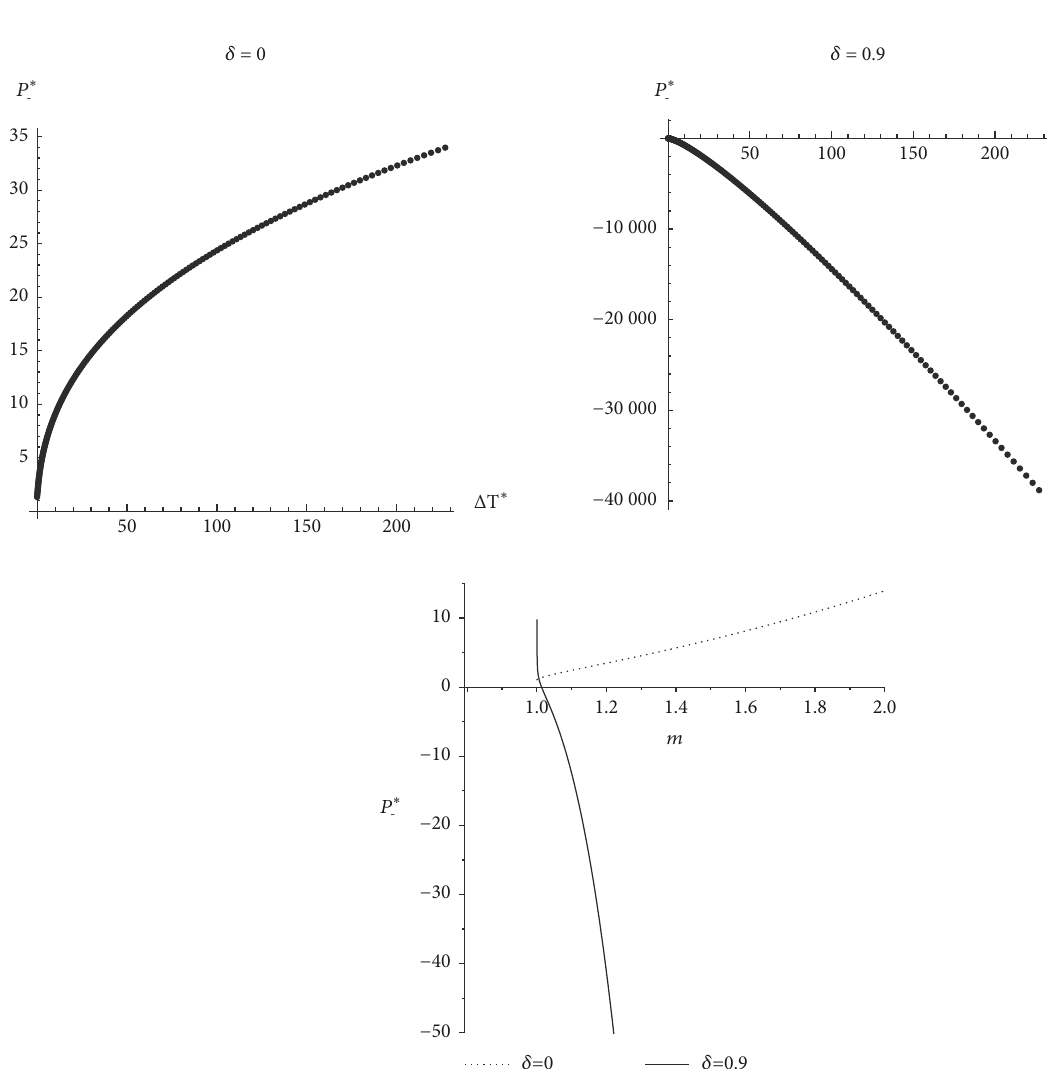
Figure 8: Diagram of interior horizon pressure 𝑃 ∗ − is plotted against 𝑚 and Δ𝑇 ∗ for 𝛿 = 0 and 𝛿 = 0.9